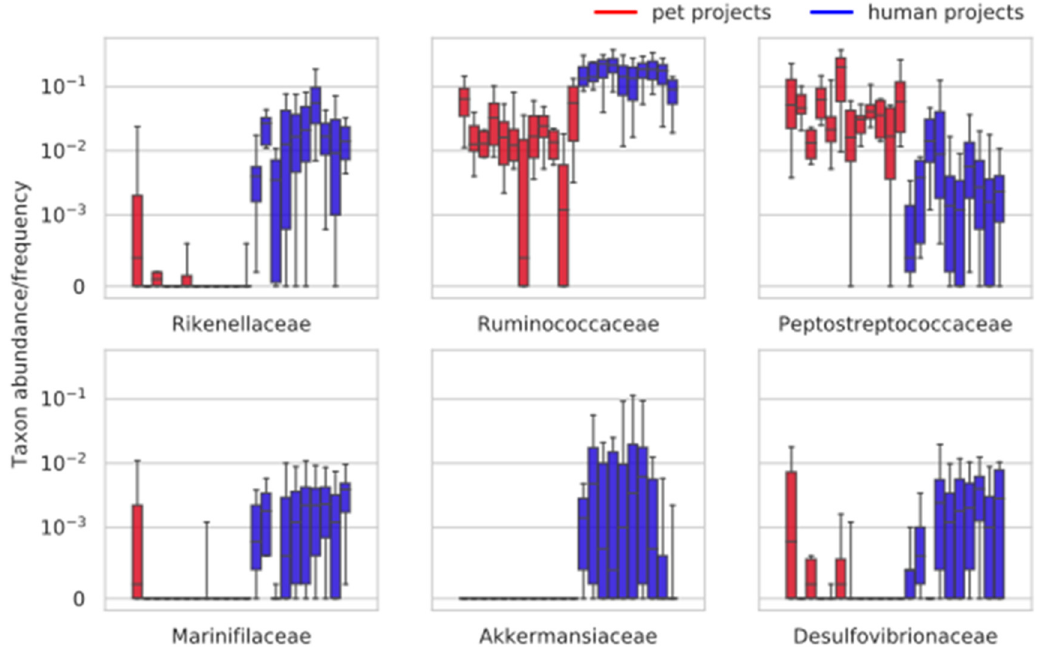
Figure 2. The di ff erentially abundant families between pets and humans. The y-axis shows the fraction of reads from the total (the axis is log-transformed). Red bars correspond to pet projects, and blue bars correspond to human projects. The families significant using the Holm correction method are shown (for families significant according to the FDR correction method, see Table